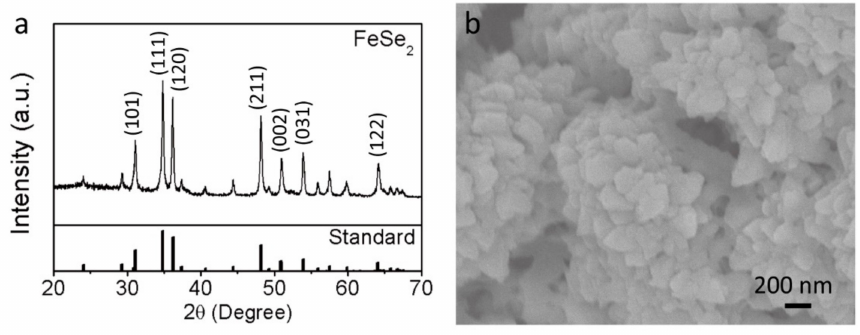
Figure 2. Characterization of FeSe 2 nanoparticles. ( a ) XRD spectrum; ( b ) SEM image of FeSe 2